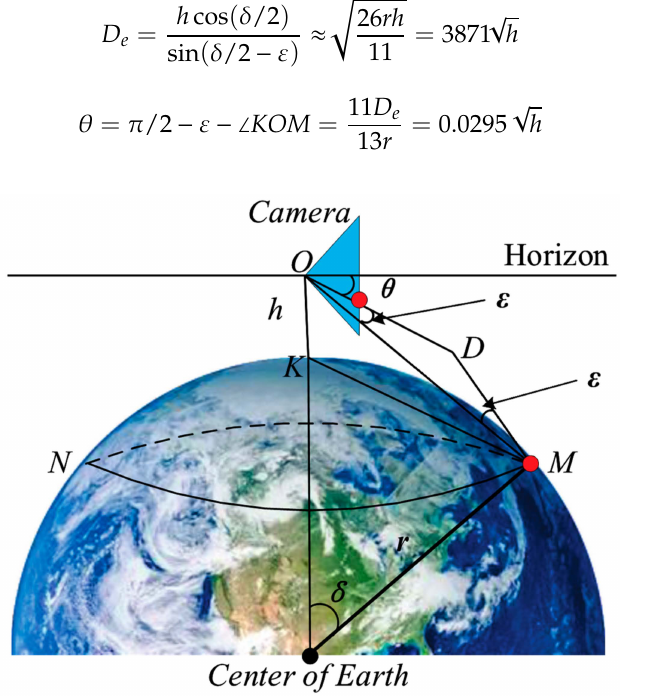
Figure 2. Geometric relationship between the big circle and the camera